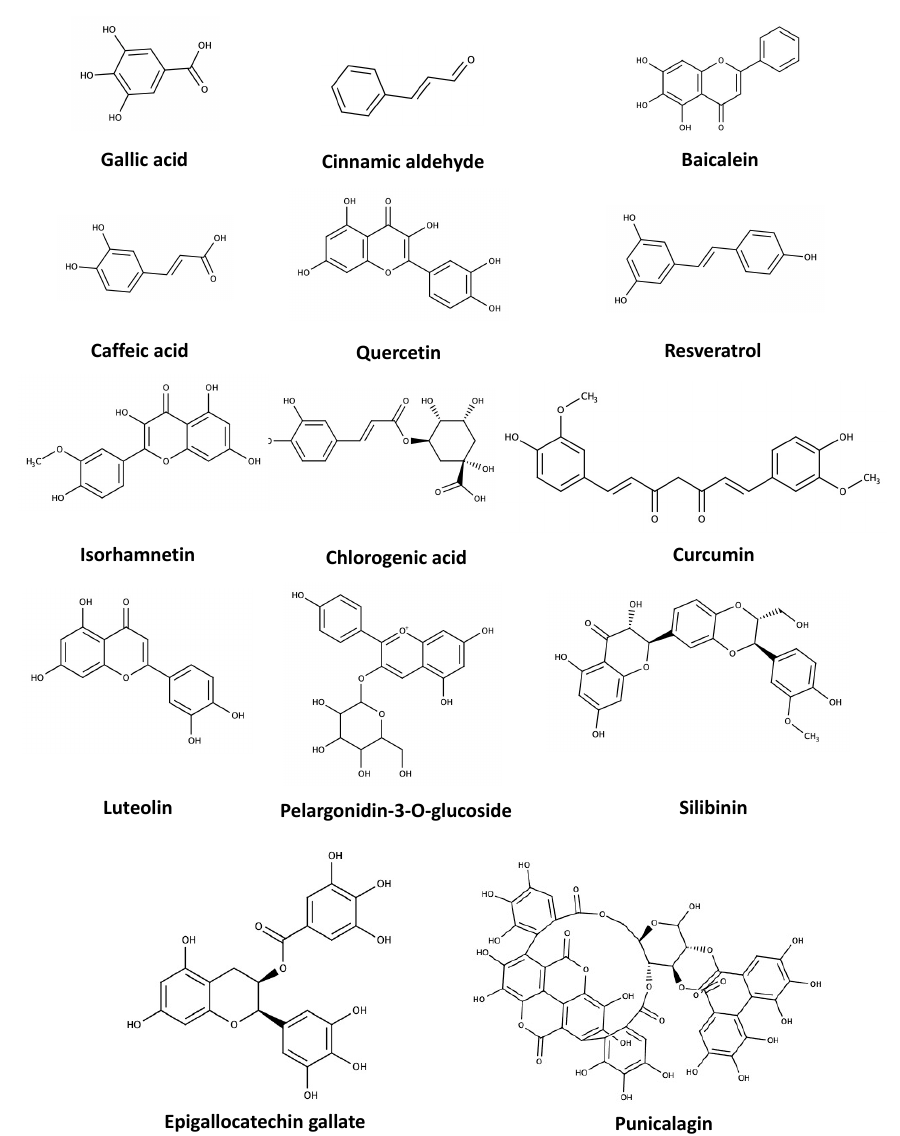
Figure 2. Structures of common polyphenolic compounds.